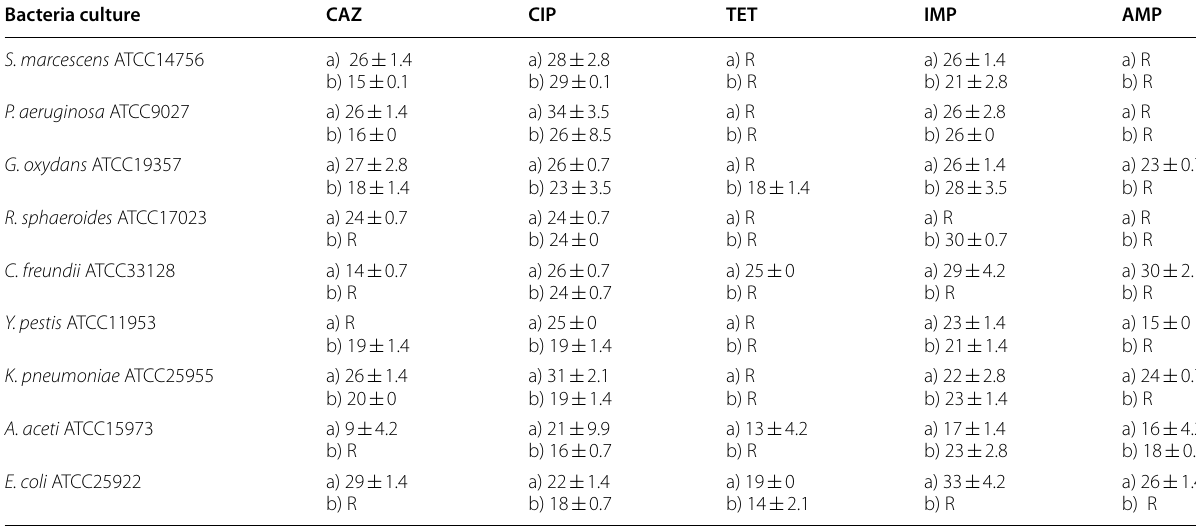
Table 5 Antibiotics susceptibility profile of selected Gram‑negative bacteria as read in mean diameter of zones of inhibition (mm) after treatment to electromagnetic flux at 5mT intensity compared with control